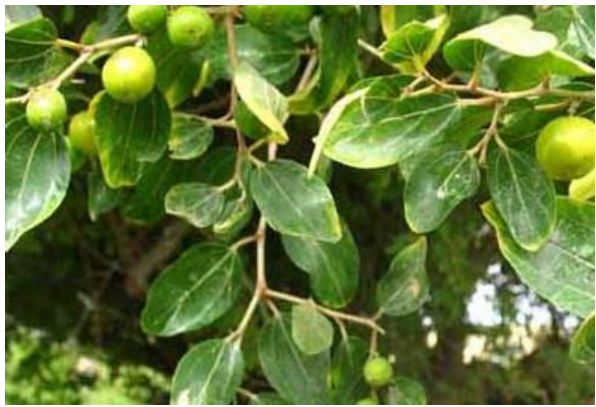
Figure 1. Aerial parts of Z. spina-christi used in this study.